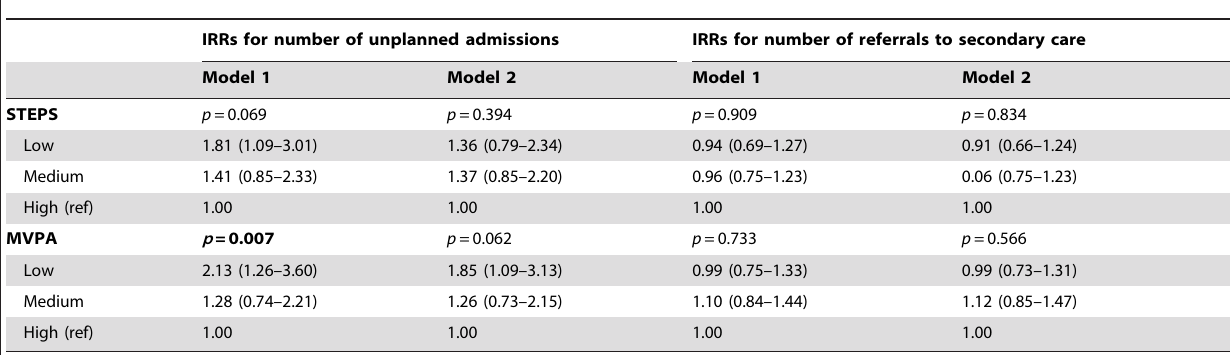
Table 4. Negative binomial regression predicting unplanned hospital admissions and referrals based on measures of physical